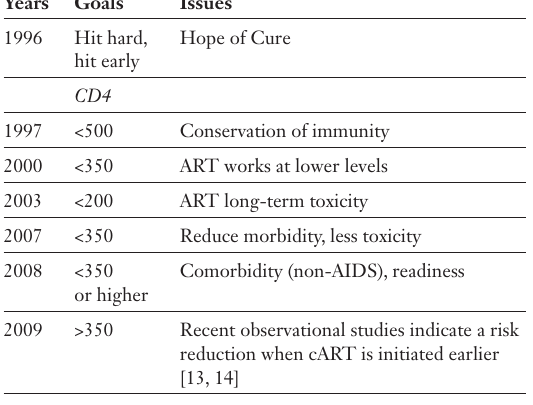
Causes of death among HIV-infected individuals in Europe